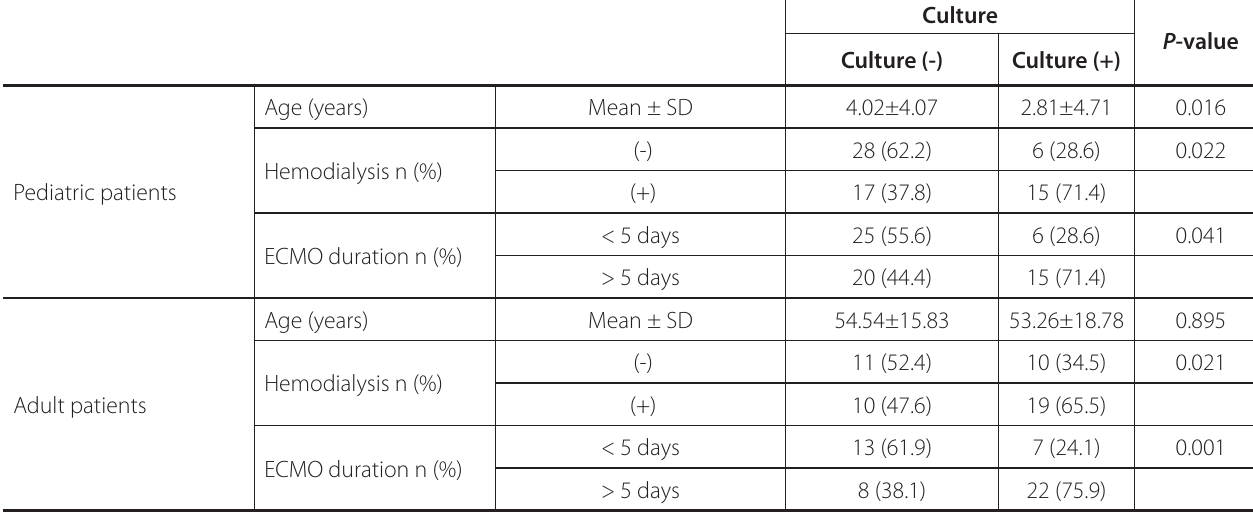
Table 6 . Patient factors for pediatric patients with respect to culture